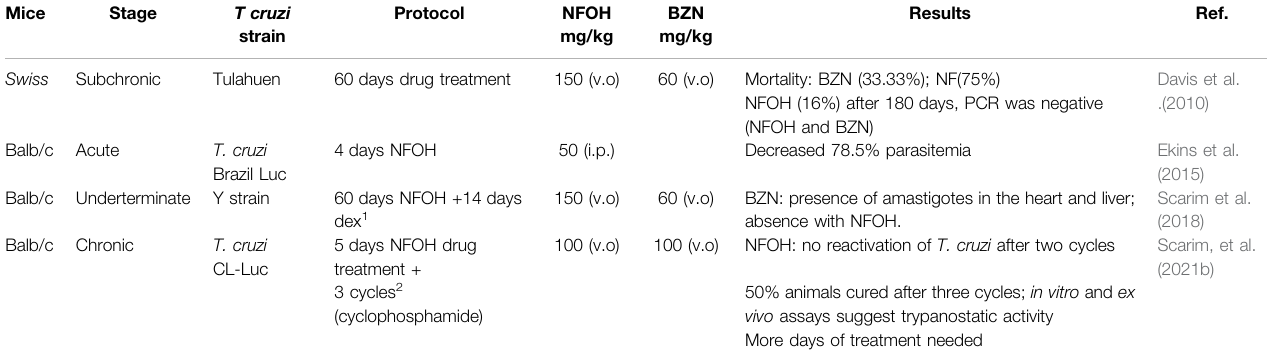
TABLE 4 | Main results accomplished with NFOH in animal studies (Davis et al., 2010; Ekins et al., 2015; Scarim et al., 2018; Scarim et al., 2021a). Mice